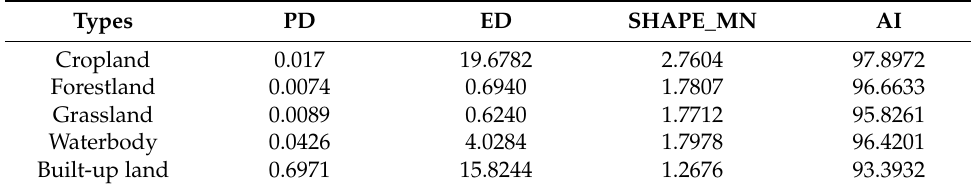
Table 2. Landscape metric values at the class